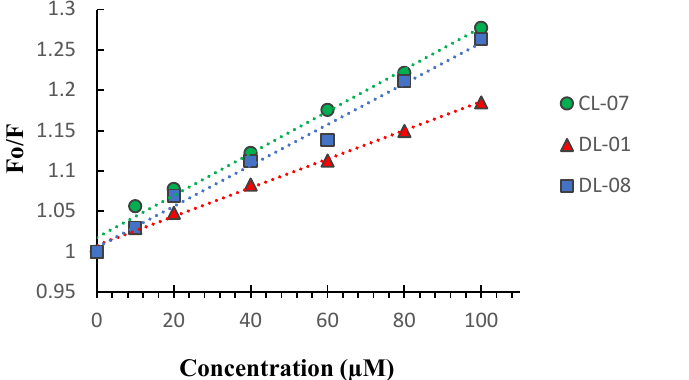
Figure 7. Steady-state fluorescence intensities of CT DNA–EtBr in the absence and presence of compounds.